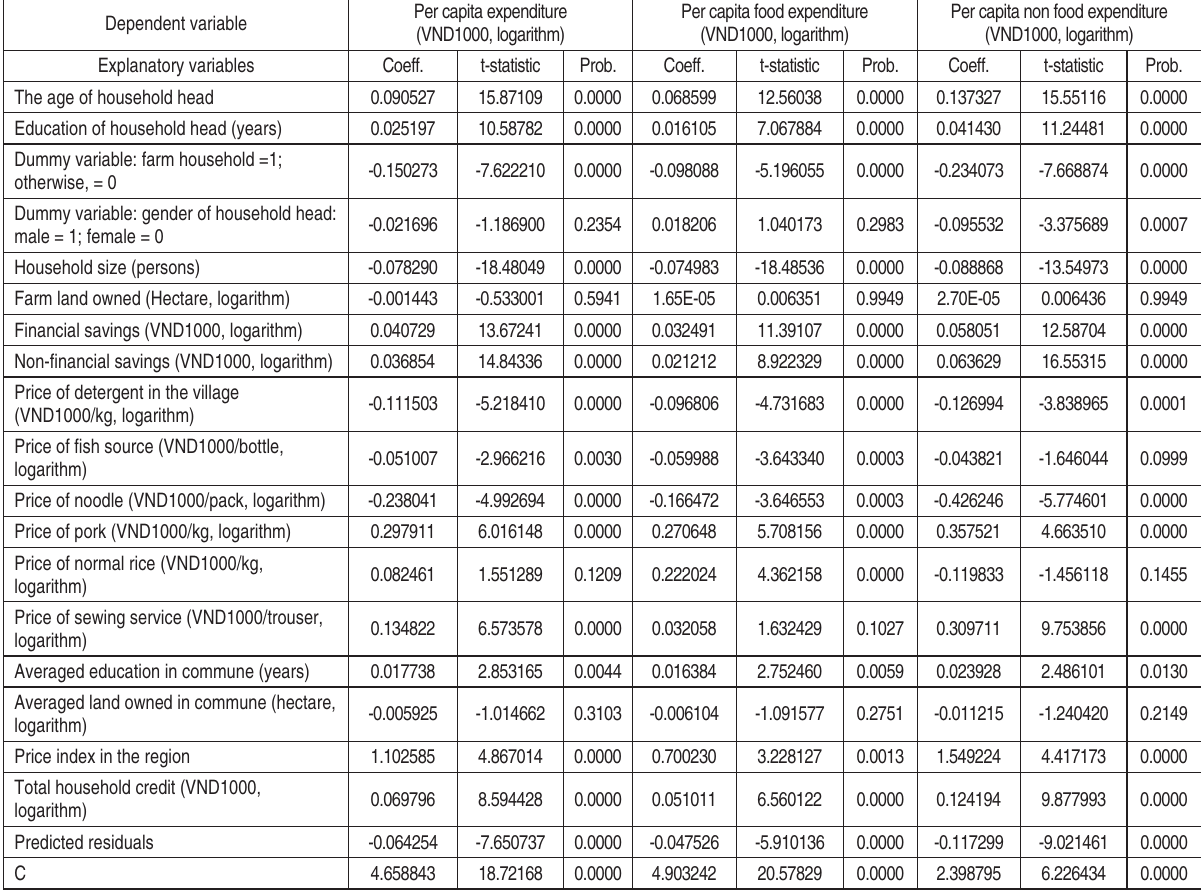
Table 5. Second stage least squares regression: effect of credit on household welfares. Survey 1 – The whole